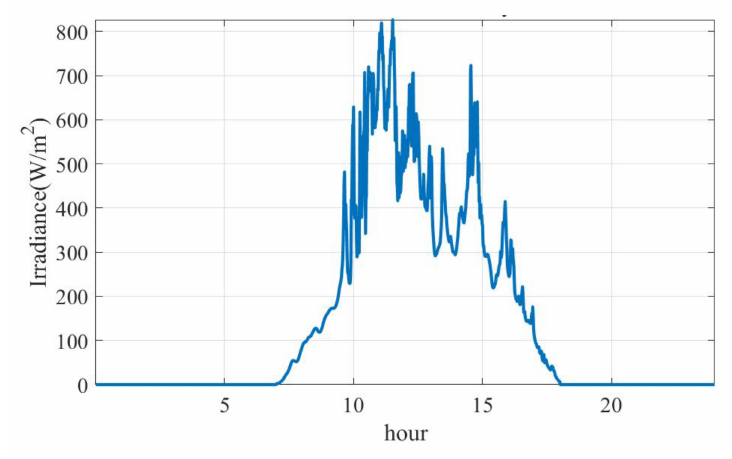
Figure 11. Measured sun irradiance throughout the day. According to the measured data, the PDFs of the wind speeds and the solar irradiance are determined, and a sample of these PDFs, at hour 17, is illustrated in Figures 12 and 13. The forecasted generated active powers from the wind turbine and the PV panel are then calculated using Equations (15) and (19).